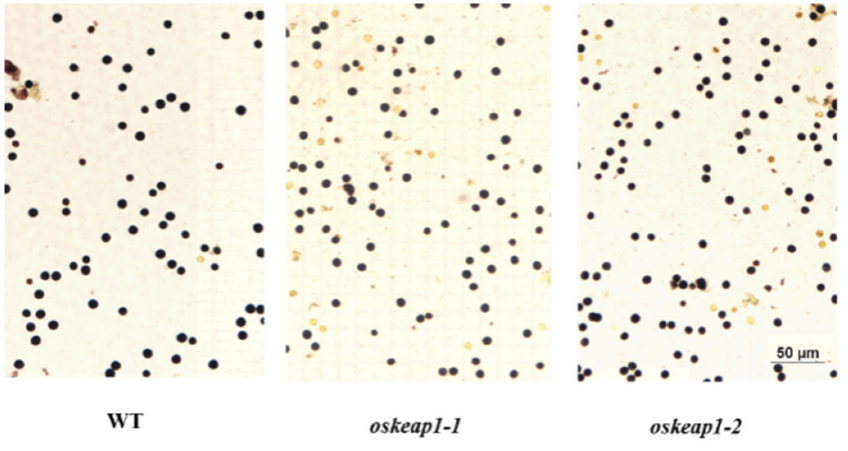
Figure 6. K-I 2 -stained rice pollen grains of Xidao #1 (WT) and its two oskeap1